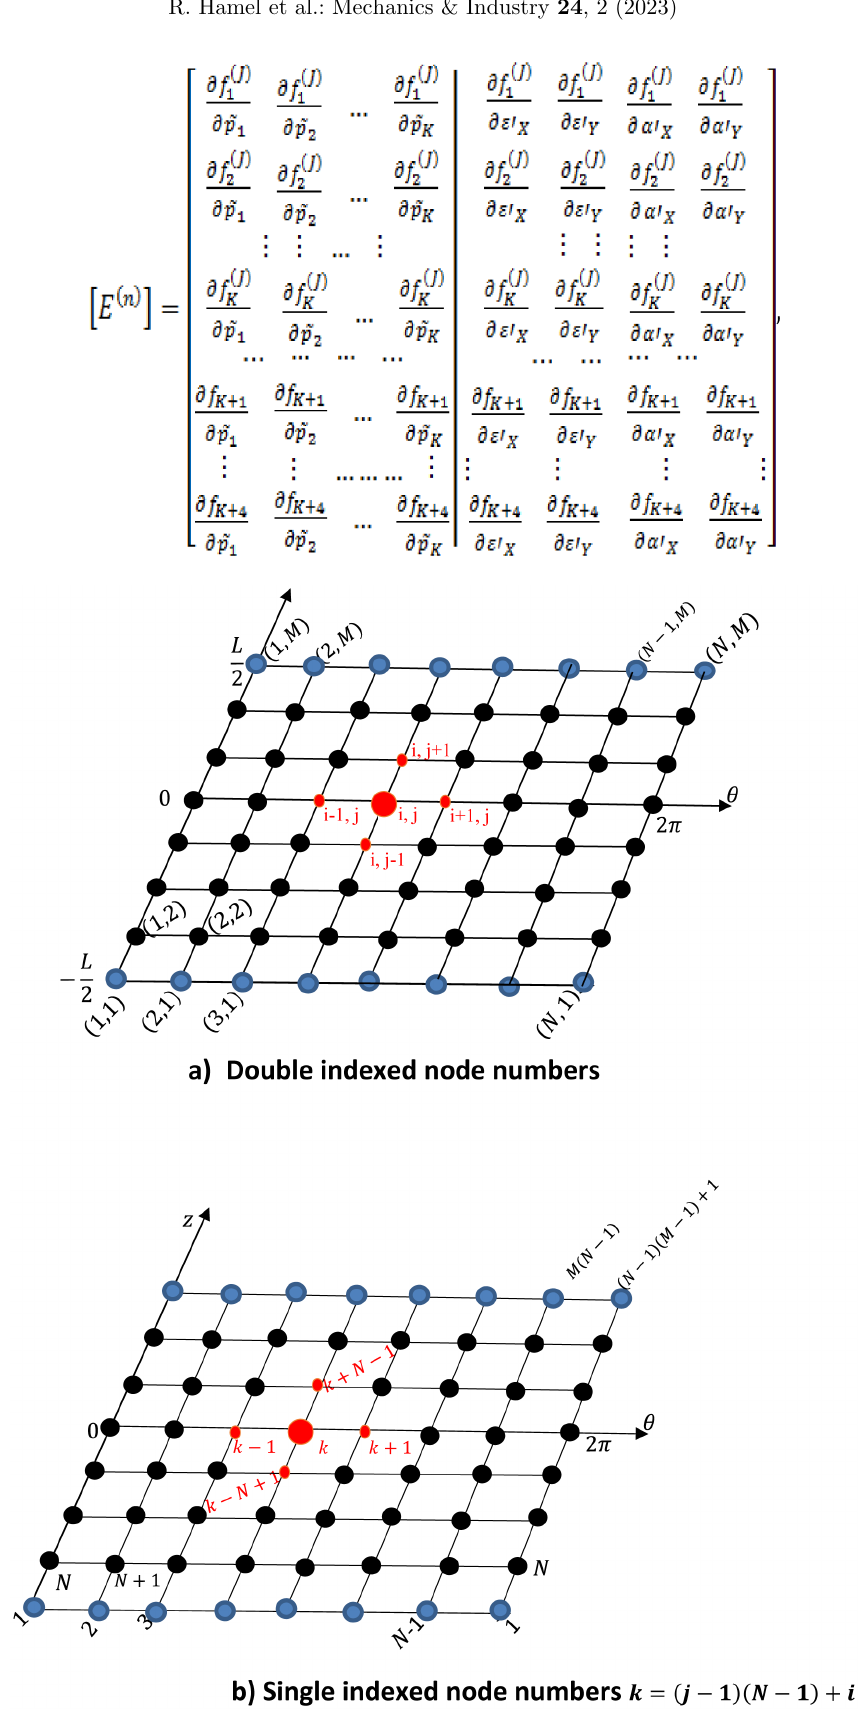
Fig. A1. 2-D orthogonal Cartesian fi nite difference grid used for spatial discretization of modi fi ed Reynolds